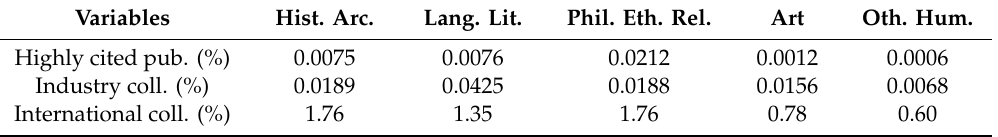
Table 2. Collaboration and highly cited publication statistics for five subareas of the humanities 2,3 . Variables Hist. Arc. Lang. Lit. Phil. Eth.